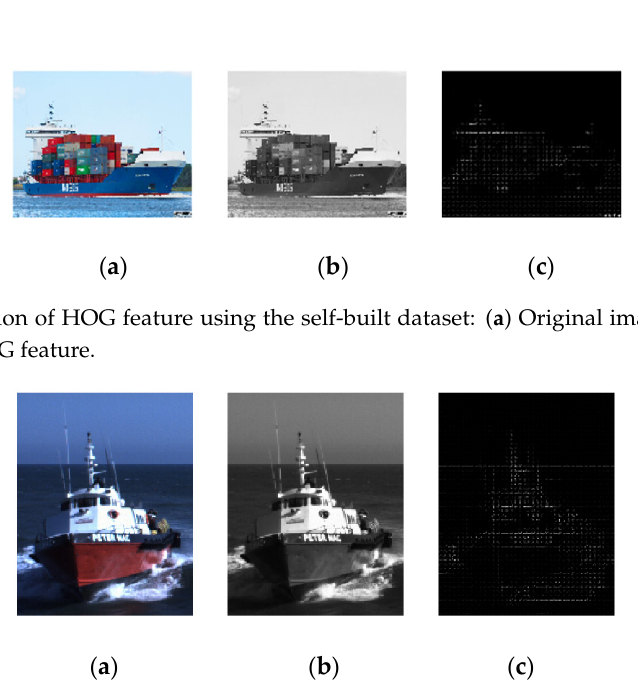
Figure 6. Classification accuracy (%) with varying parameters of histogram of oriented gradients (HOG) for two experimental data: ( a ) The self-built dataset and ( b ) the visible and infrared spectrums (VAIS) dataset.